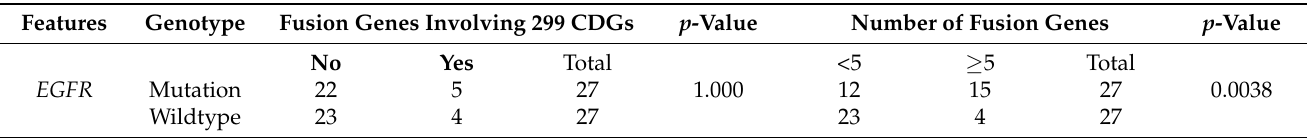
Table 3. Correlation between fusions and EGFR